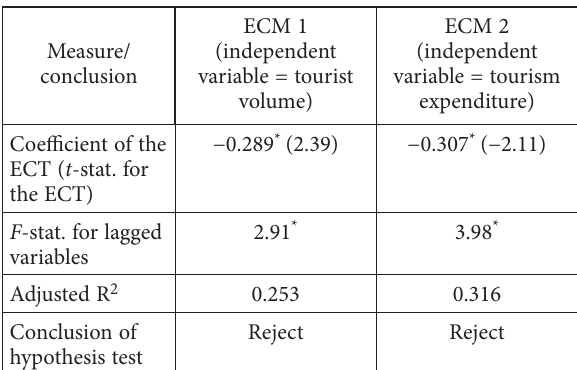
Table 4. Results of ECM-based Granger causality tests for the